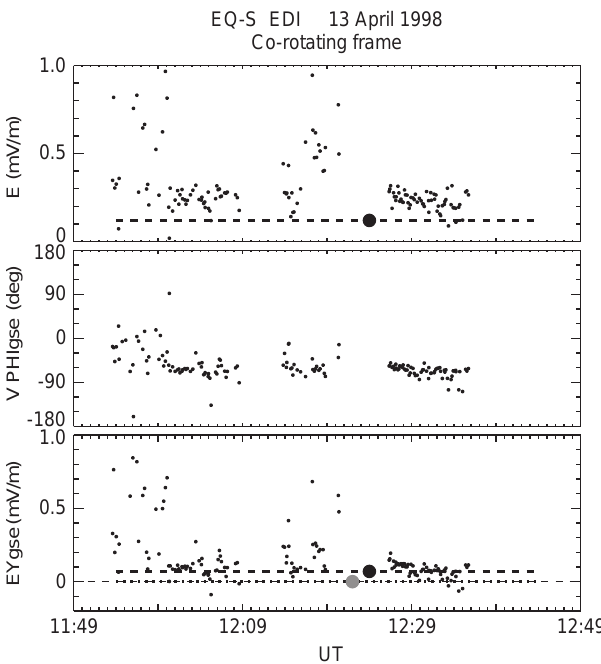
Fig. 9. April 13, 1998 measurements in the co-rotating frame. Same format as Fig. 5. Missing data (12:09–12:13 and 12:20–12:26) are gaps in EDI triangulation telemetry during